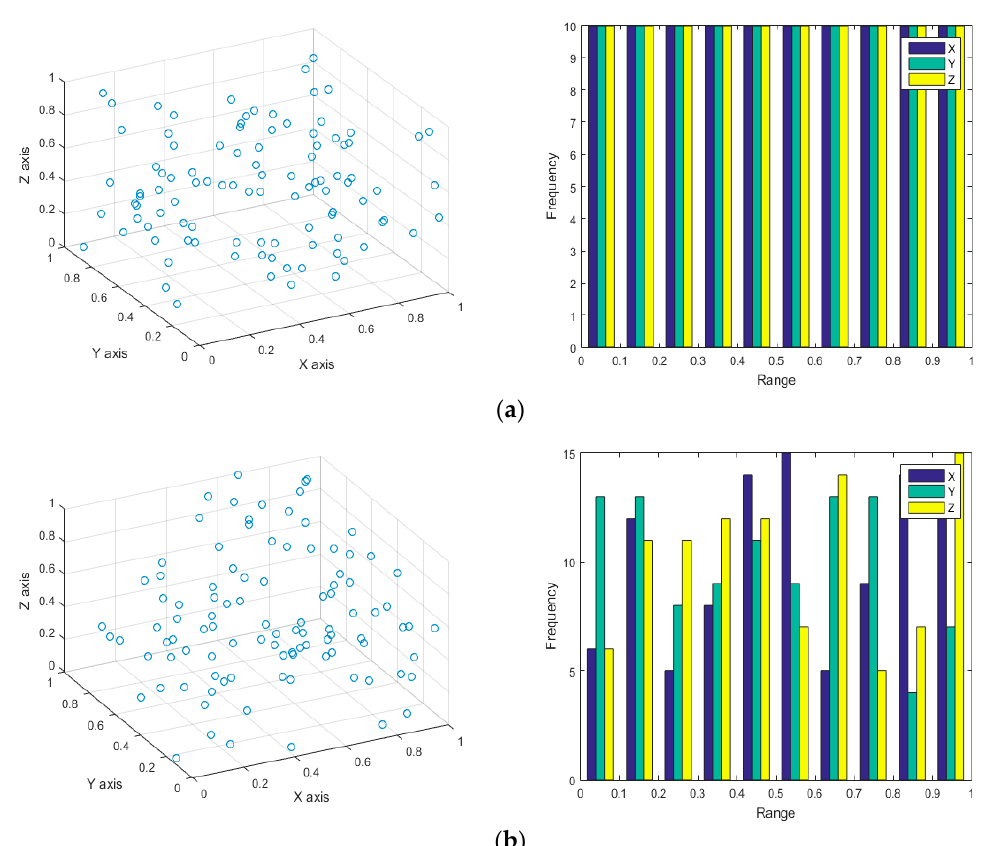
Figure 3. Comparison of the two sampling methods—( a ) Latin hypercube sampling and ( b ) random sampling.